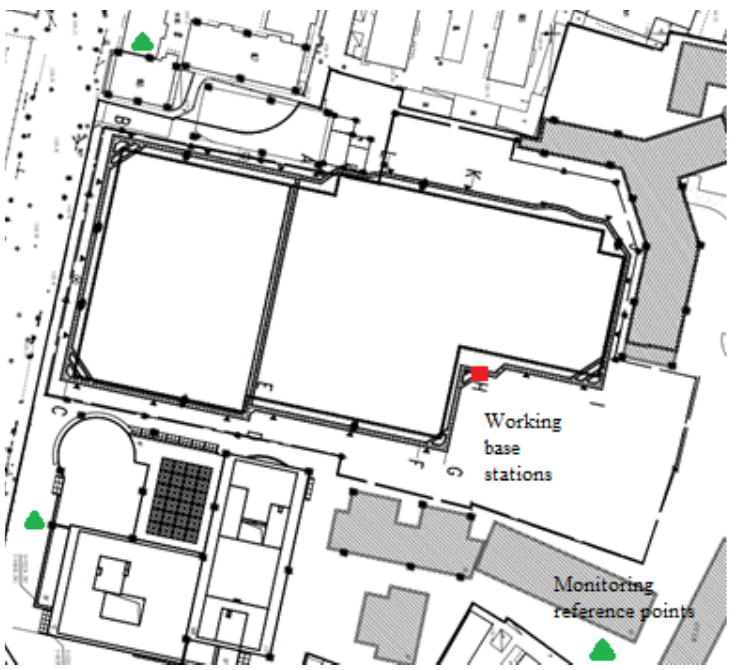
Figure 9. Layout plan of monitoring points of foundation pit.